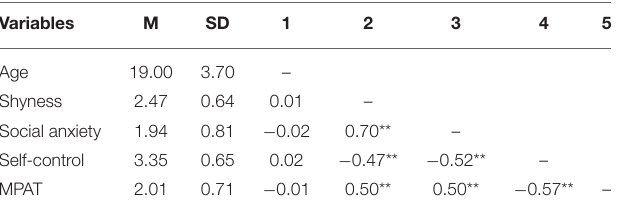
TABLE 2 | Descriptive statistics and correlation matrix of all